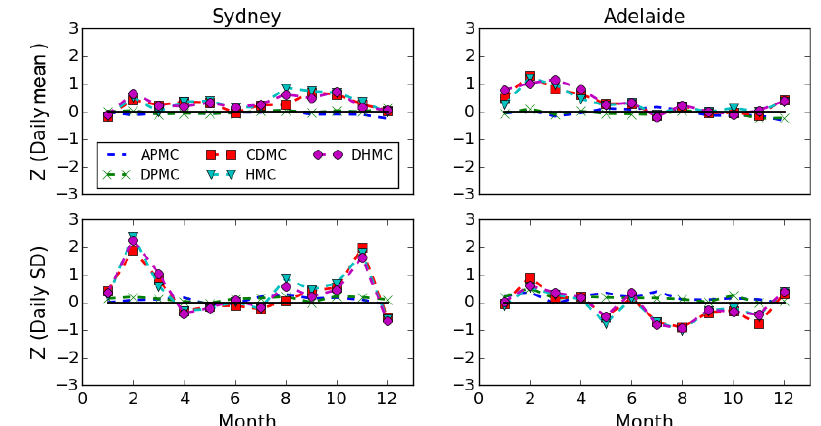
Figure 7. Comparison of the mean and SD of daily rainfall depths for the five MC models.